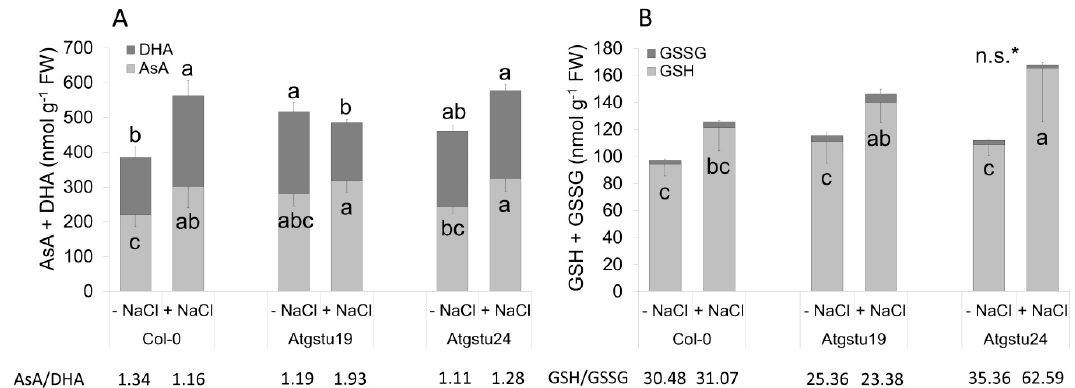
Figure 4. Ascorbate and glutathione contents of two-week-old wild-type (Col-0) and GSTU mutant ( Atgstu19 and Atgstu24 ) Arabidopsis plants treated with 150 mM NaCl for 48 h. ( A ) The reduced ascorbic acid (AsA) and the oxidized dehydroascorbate (DHA) contents in seedlings. ( B ) Reduced (GSH) and oxidized (GSSG) glutathione contents in seedlings. Means ± SD. Means denoted by di ff erent letters